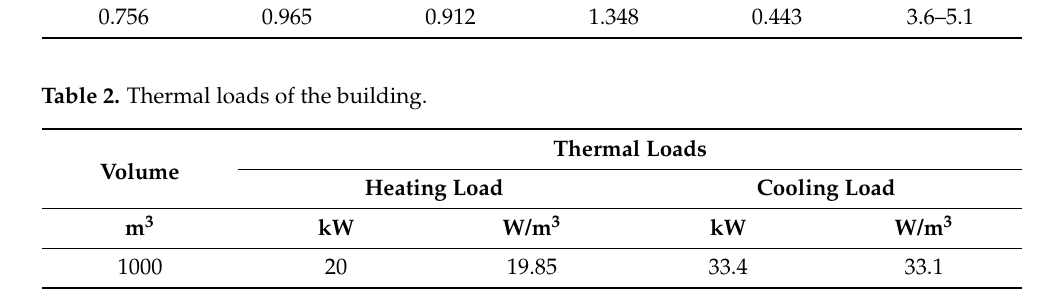
Figure 7. Three-dimensional model of the building. Table 1. Stationary thermal transmittance of the case study building envelope (W/m 2 K). U wall,1.